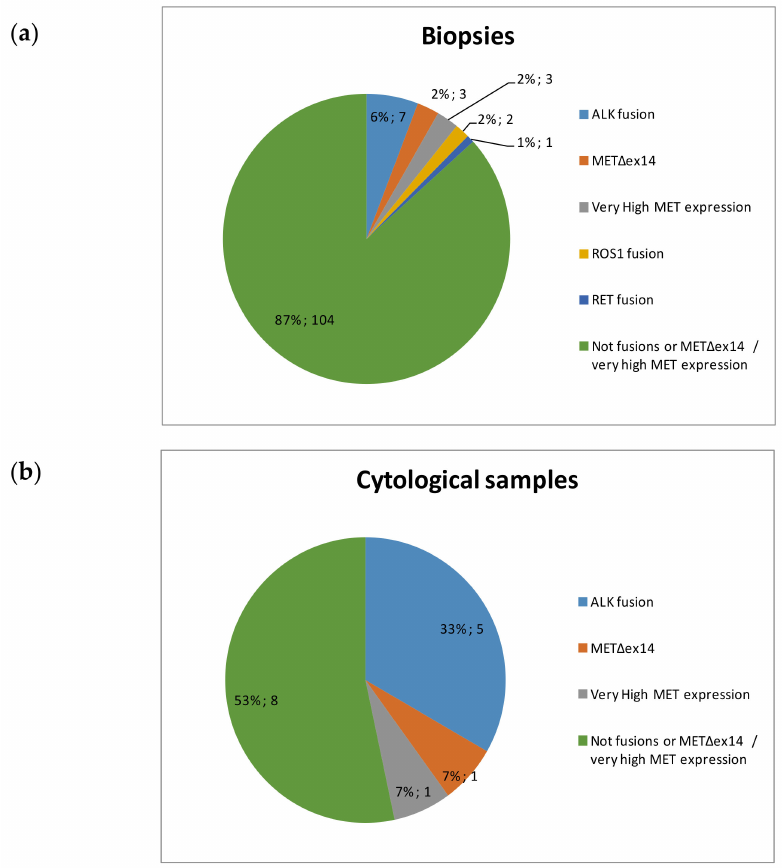
Figure 3. Distribution of alterations detected by nCounter in ( a ) biopsies ( b ) cytological samples. Four ALK cytological samples were positive by 5 (cid:48) /3 (cid:48) imbalance and specific fusion probes; three corresponded to variant 1 and the remaining sample to variant 3. The other ALK cytological sample was positive only by 5 (cid:48) /3 (cid:48) imblance (Table 4). Three of the ALK cases could be confirmed by IHC and another by FISH, while the specimen with the MET ∆ ex14 was confirmed by RT-PCR and NGS (Figure 4). The sample with very high MET expression was submitted to IHC, FISH and NGS. The results were MET amplification by both FISH and NGS (ratio MET/CEP7 > 5 and copy number = 25.12, respectively) and high protein expression (histoscore = 240), as expected (Figure 4 and Table 4). Finally, 11 out of 15 cytological samples yielded valid results by NGS. Amplifications in EGFR ( n = 2), ERBB2 ( n = 2) and CDK4 ( n = 1) and mutation in ERBB2 ( n = 1) were detected, which were mutually exclusive with fusions and MET skipping variant. No mutations in driver genes such as KRAS or EGFR were